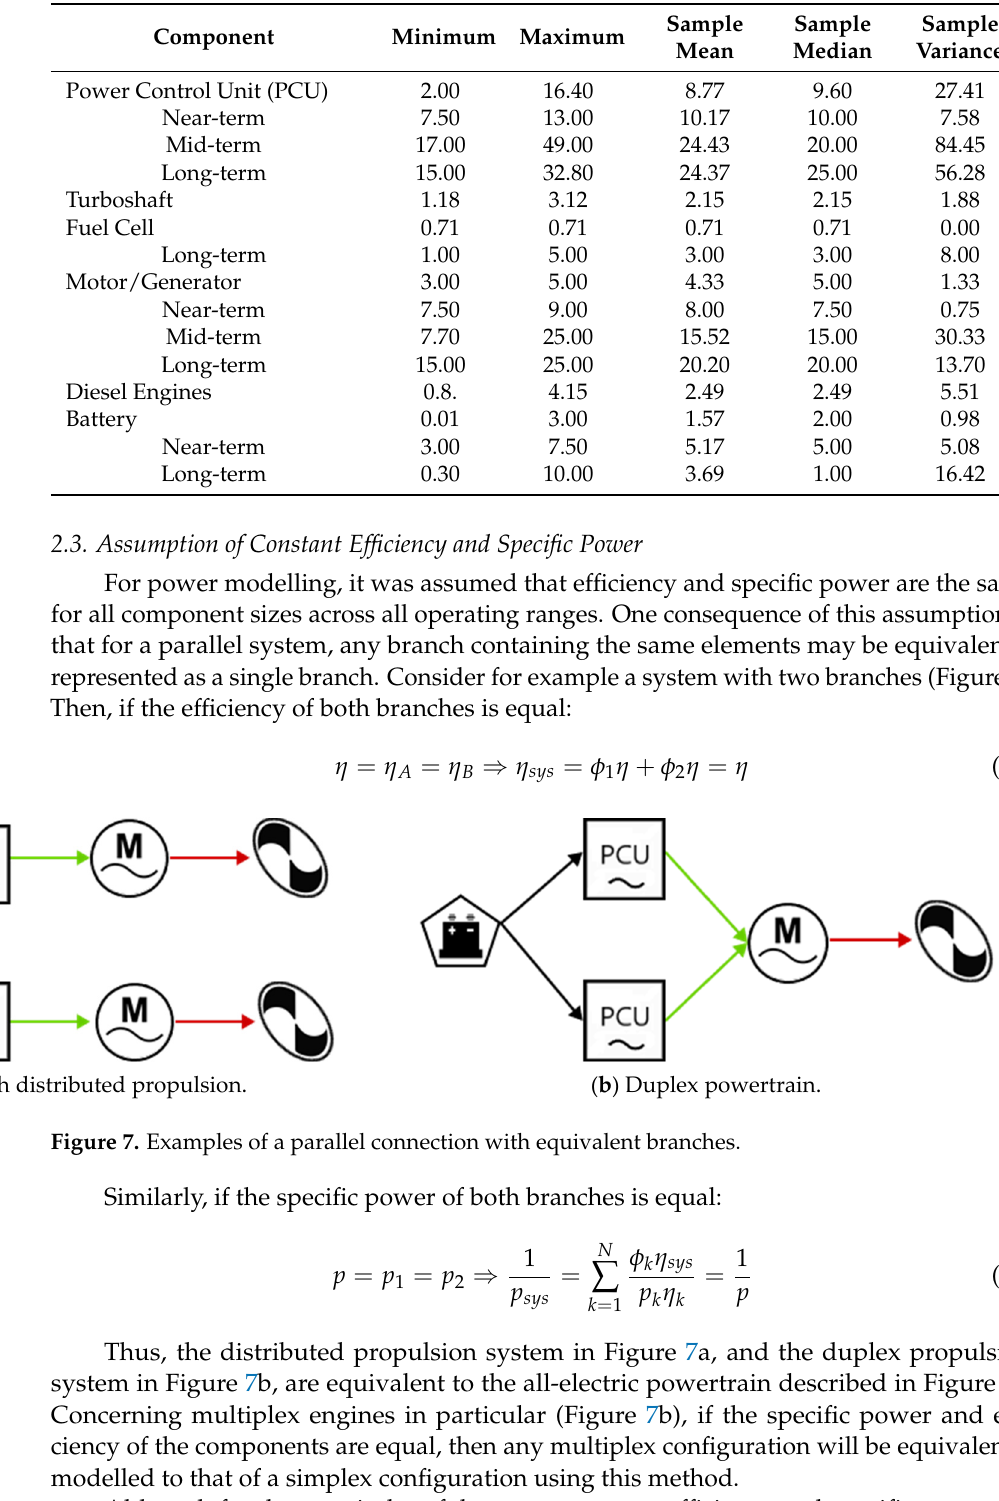
Table 3. Compiled values of state-of-the-art component specific power, p X [kW/kg].